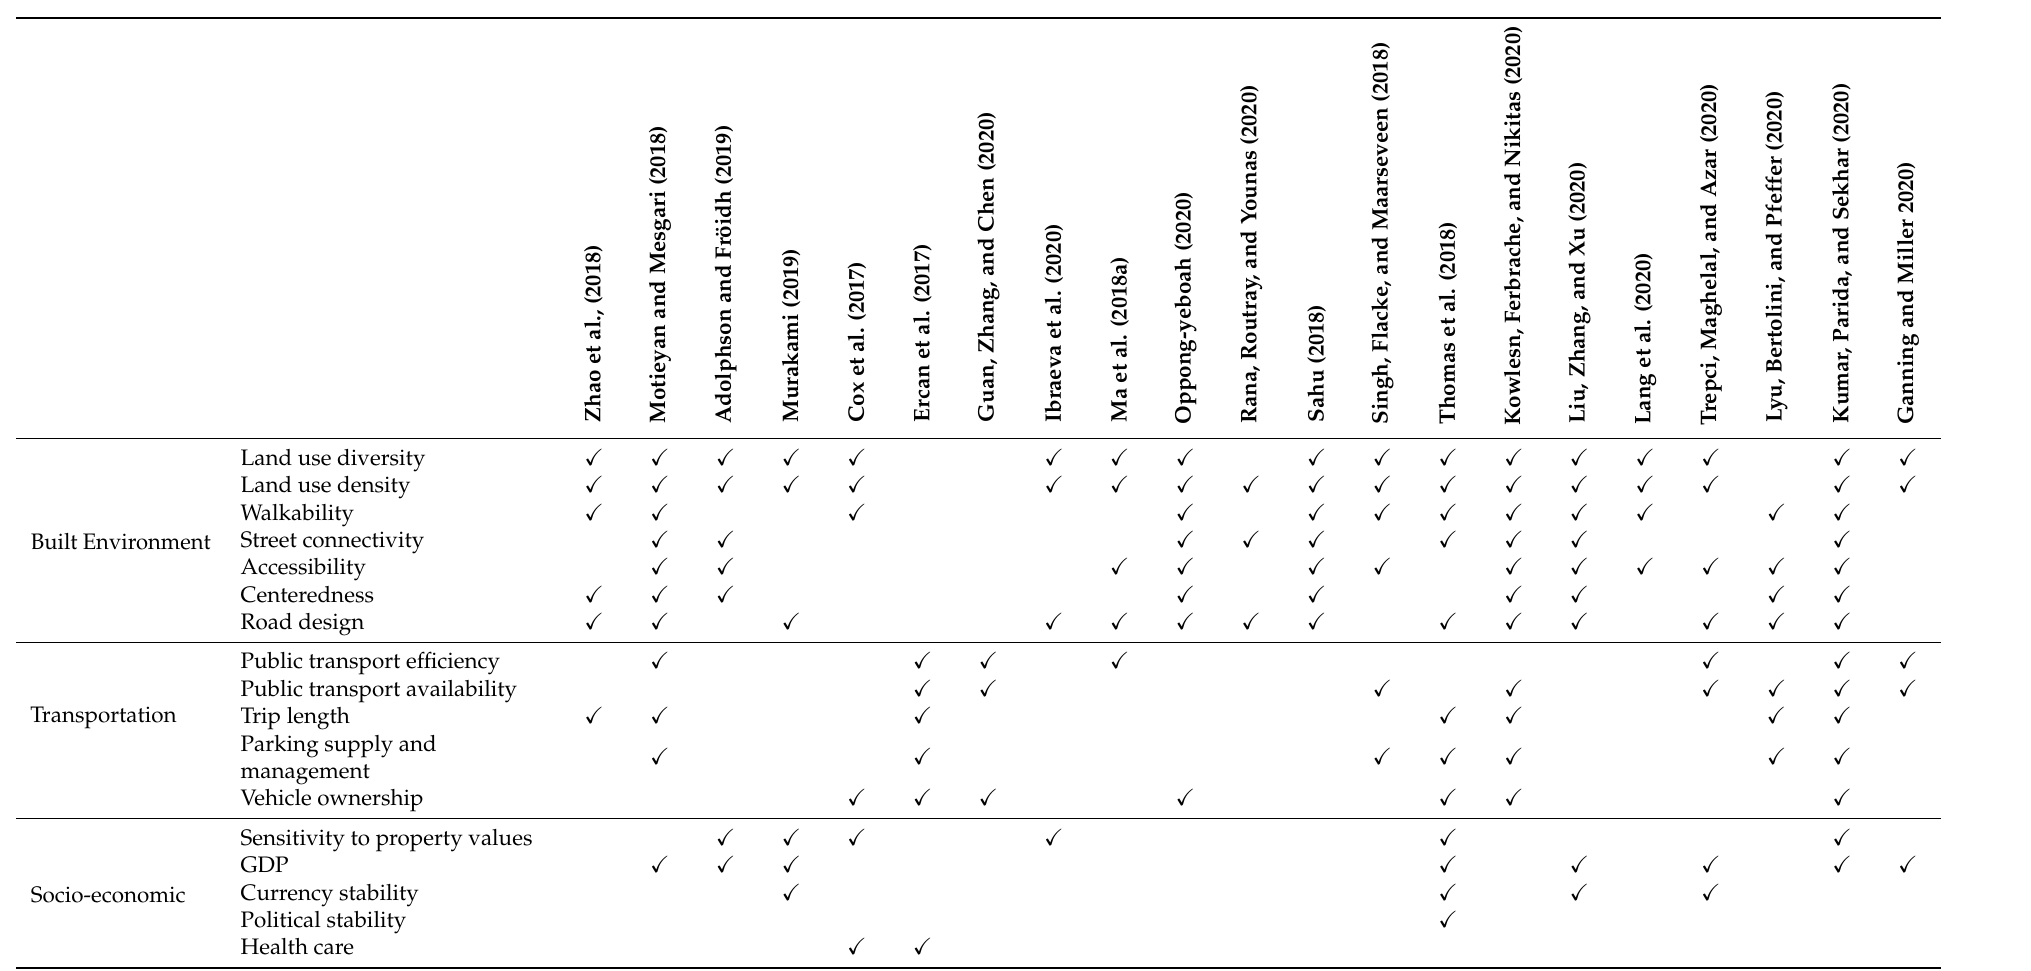
Table 1. Literature summary—Smart transport